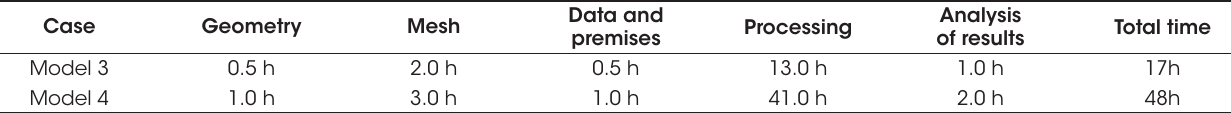
Average time for each step — Mesh (04)